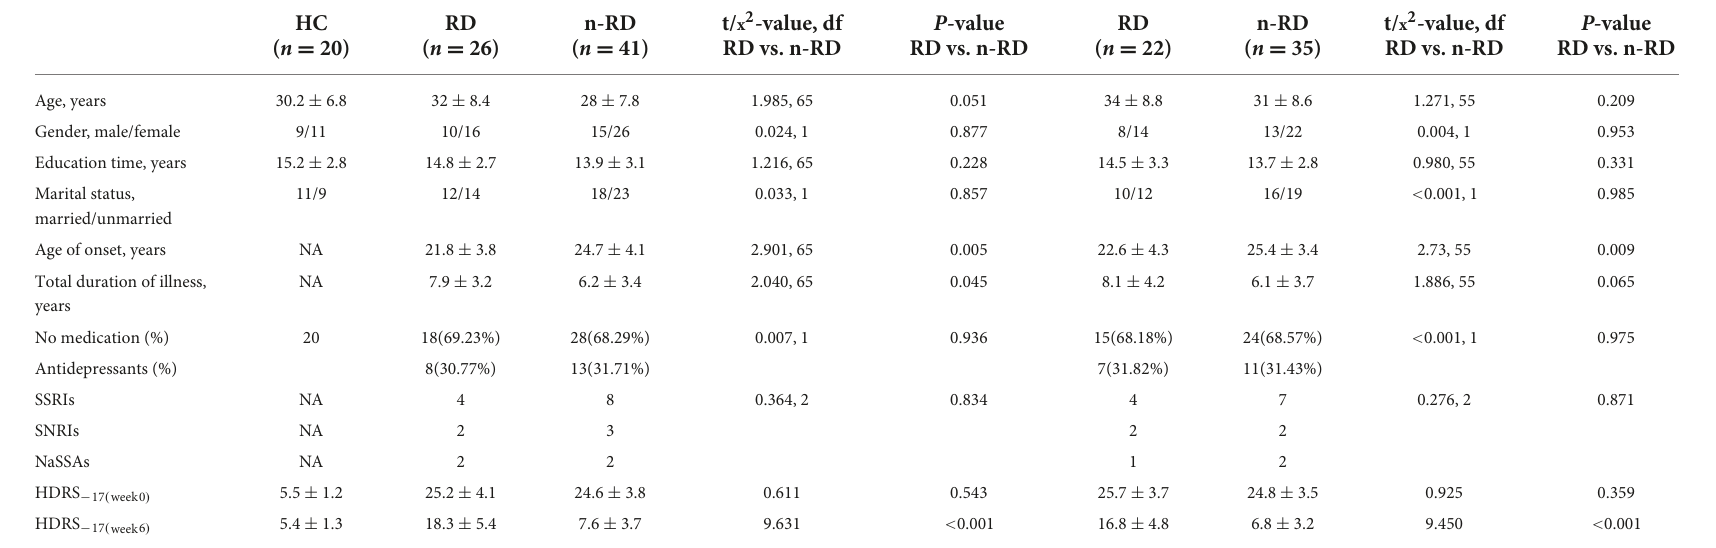
TABLE 1 Demographic and clinical